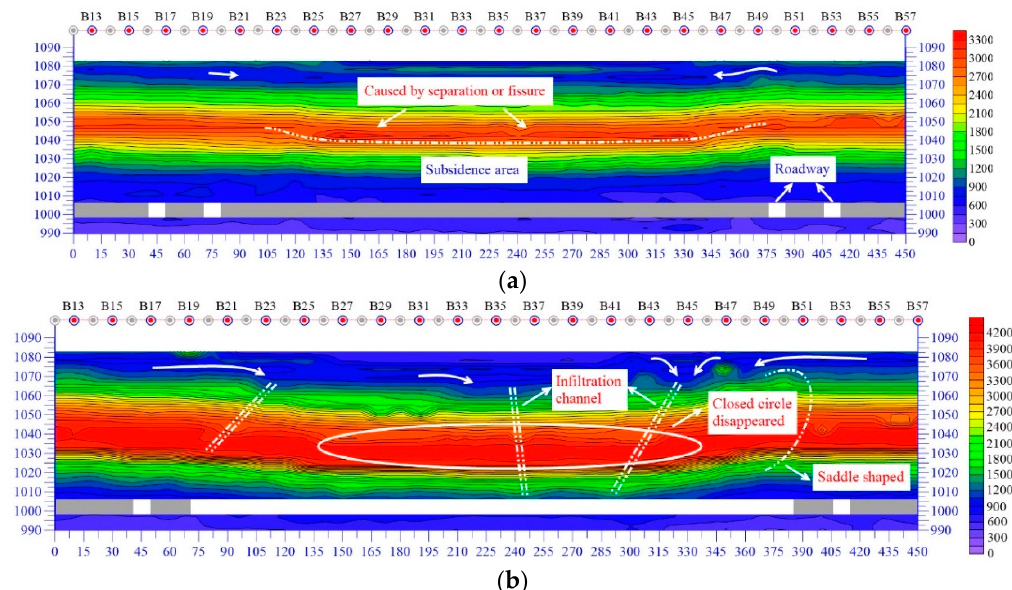
Figure8. ARcontoursoflineBunderdi ff erentminingconditions( a )Duringminingand( b